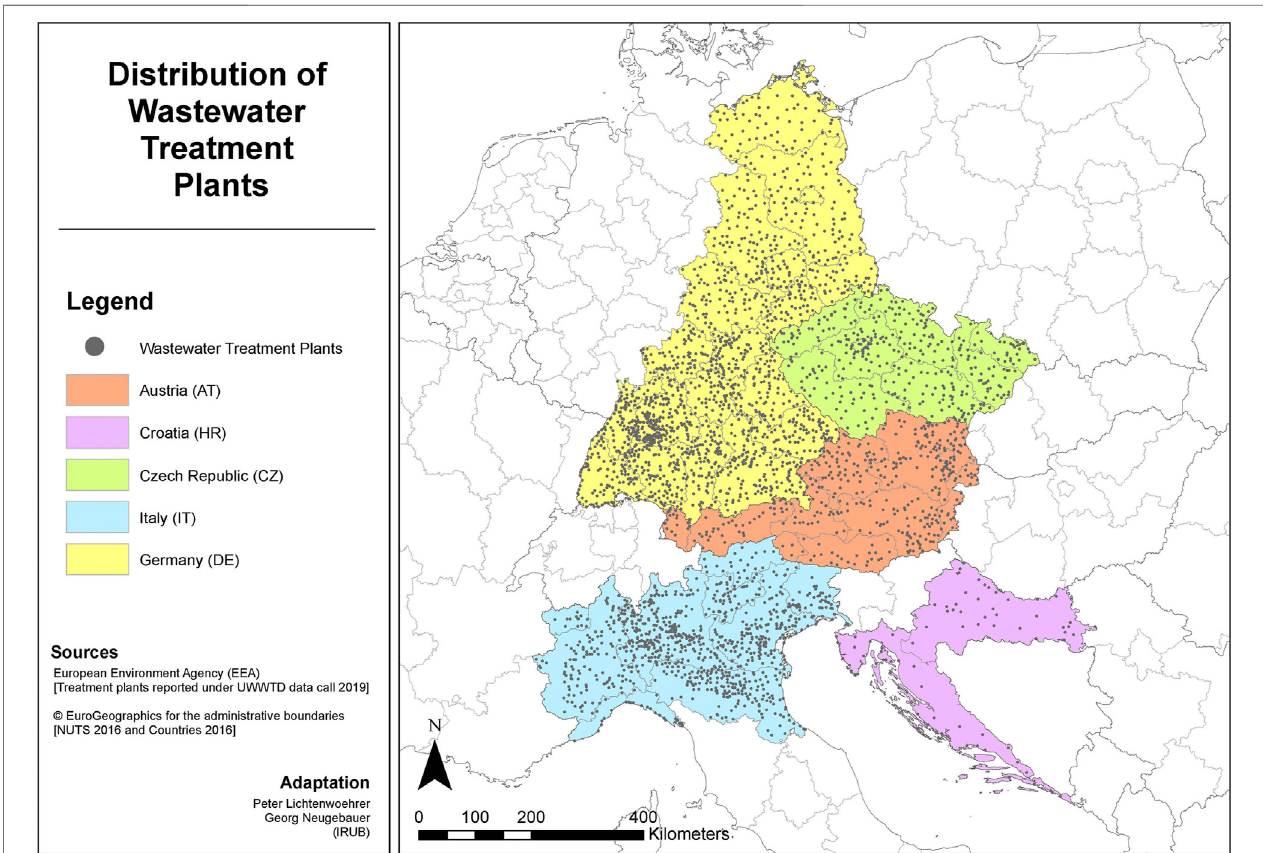
FIGURE 2 | Distribution of WWTPs in the research area (own